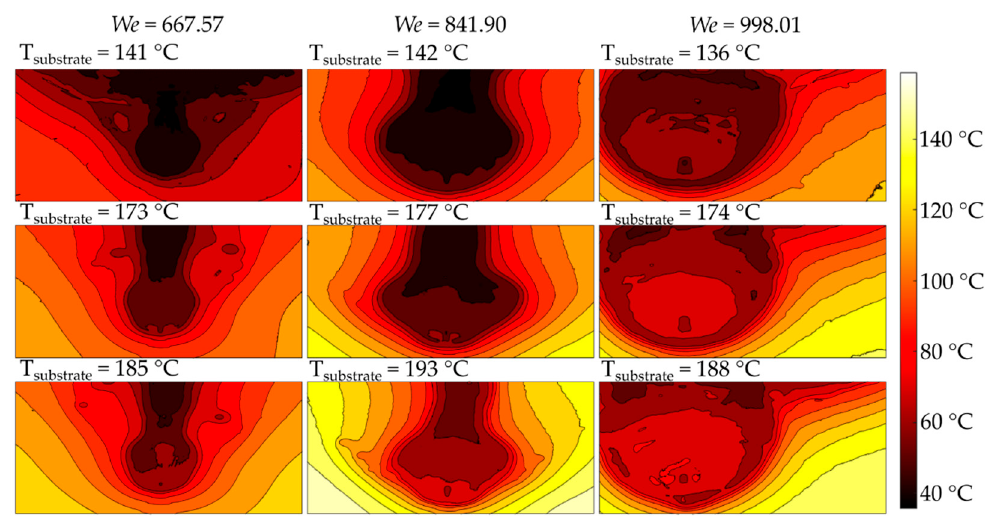
Figure 6. Steady-state thermographic images of ethanol droplet train impingement on the target glass surface at different Weber numbers for the surface temperature values of 135.00 °C to 200.00 °C.